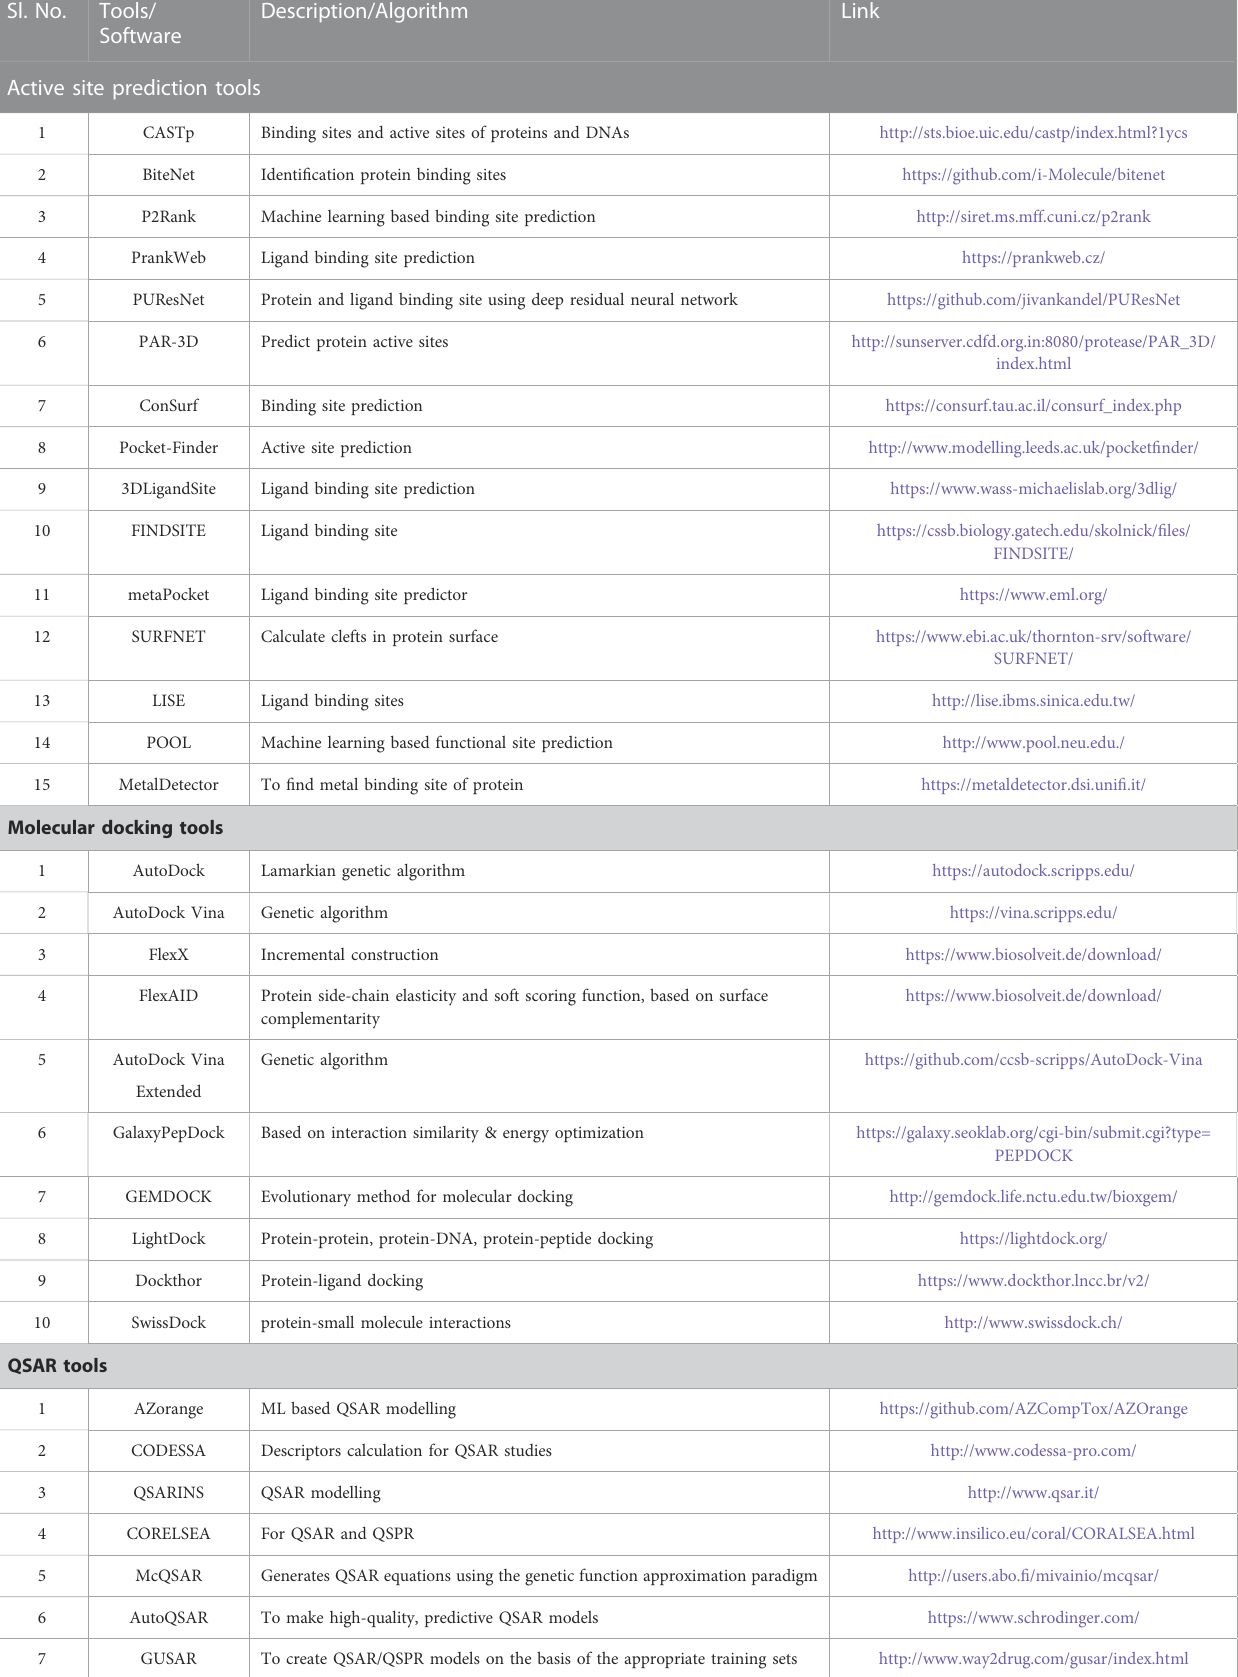
TABLE 1 List of Software/Tools which are being used for identi fi cation of lead compunds against TB. Sl. No. Tools/ Description/Algorithm Link Software Active site prediction